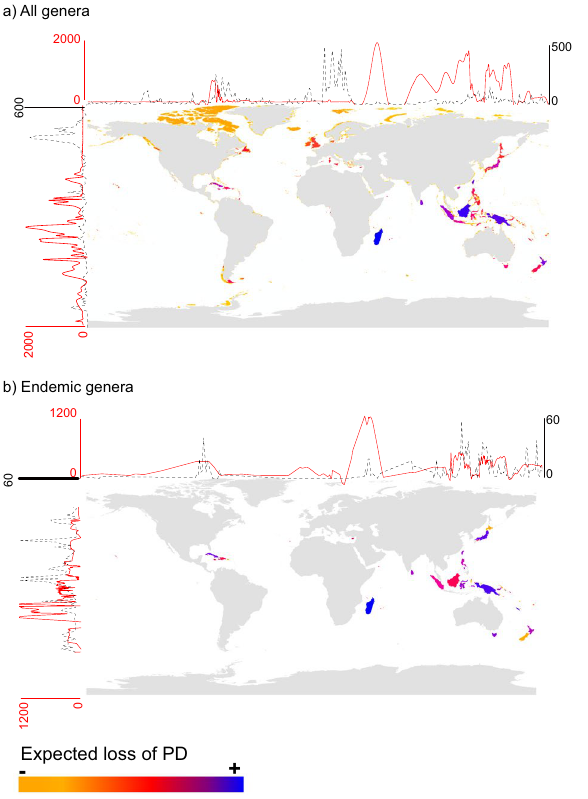
Figure 2. Distribution of the ExpPD loss caused by the independent loss of islands when considering ( a ) all monocot genera (n = 1,497) found on islands worldwide (n = 5,565); ( b ) only monocot genera that are endemic (n = 96) to islands (n = 72). Red lines represent the fitted levels of expected diversity loss (cubic smoothing spline) along longitudes and latitudes. Black dashed lines represent the fitted of the number of islands (cubic smoothing spline) along longitudes and